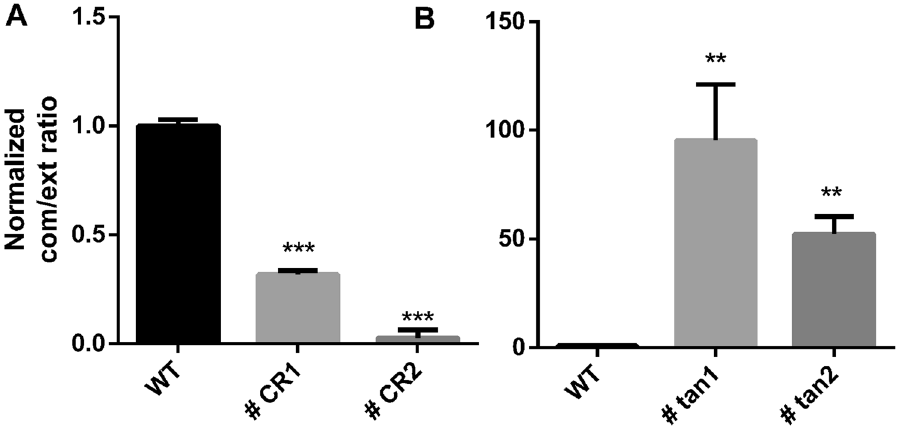
Figure 2. qRT-PCR validation of APA switching in mutated cell lines. qRT-PCR was performed with the primers shown in Fig. 1 and Supplementary Table 1. The ratio of common/extended products in mutated cell lines was normalized to that of the wild type cell line. The #CR1 and #CR2 clones were mutated to use the APA-1 site with sgccnd1CR-1 and sgccnd1-CR2, respectively, and the #tan1 and #tan2 clones were mutated to use the APA-2 site with sgccnd1tan-1 and sgccnd1tan-2, respectively. Data are represented as the mean + / − SEM (n = 3); Student’s t-test: * P < 0.05, ** P < 0.01, *** P <